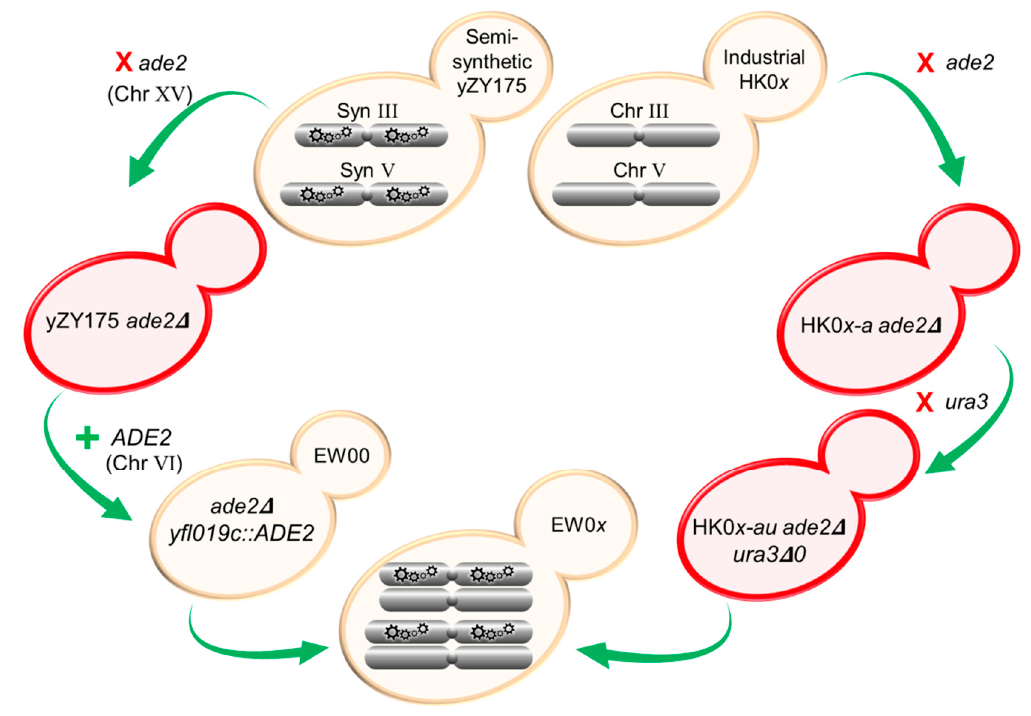
Figure 1. Strategy to generate RED-enabled heterozygous diploid S. cerevisiae strains. Native ade2 and ura3 were removed from industrially derived HK01–HK04 haploid strains. Native ade2 was also deleted from Chr XV in the semi-synthetic yZY175 strain, and functional ADE2 was re-introduced into Syn Chr VI replacing the non-essential YFL019C gene. In this locus, ADE2 is flanked by the existing loxPsym sequences. Mating of the two modified parental haploids generated RED-enabled EW01–EW04 containing native (non-synthetic) chromosomes from HK01–HK04 (MATa) and synthetic chromosomes from yZY175 (MAT α ). Colors of yeast strains shown in this figure are representative of the color of strains following each genetic manipulation. Table 2. Summary of relevant S. cerevisiae strains used in this study. Description Genotype